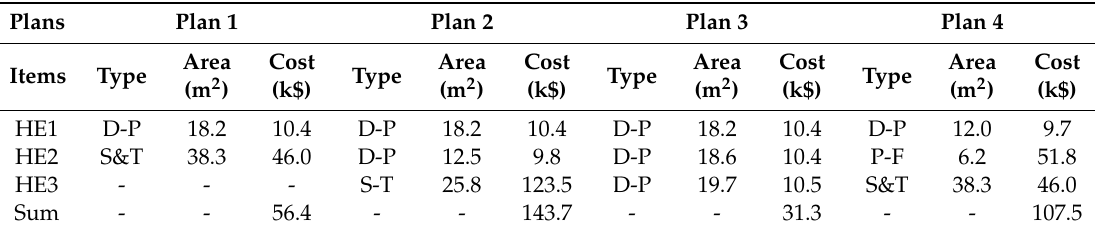
Table 4. Comparison of the results for Example 1.